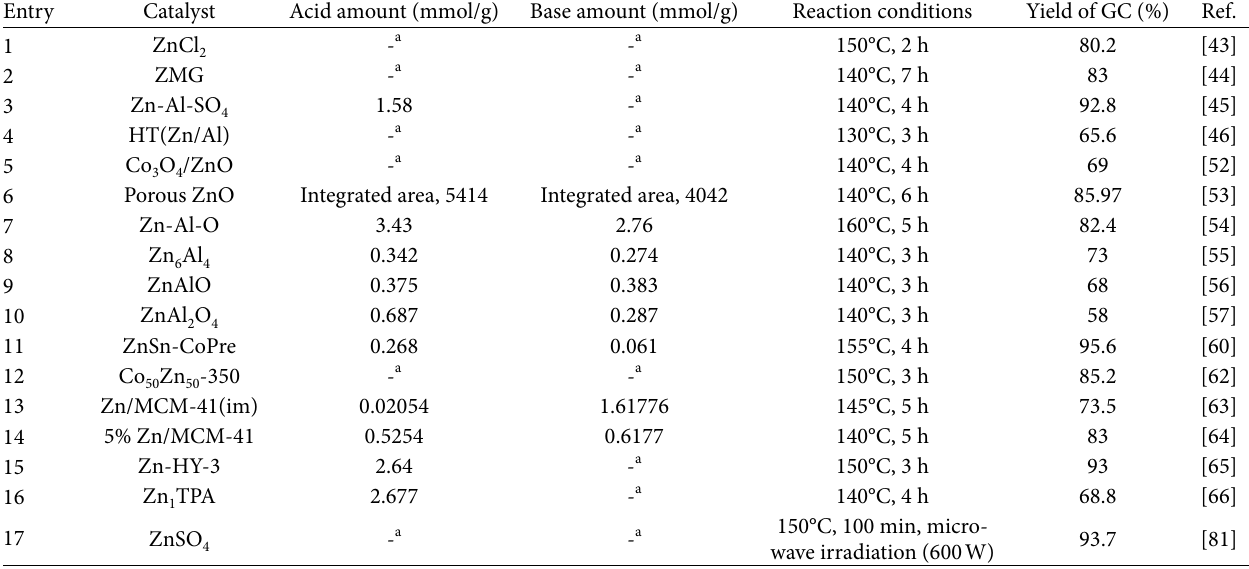
Table 1: Catalytic glycerolysis of urea to GC using zinc-based